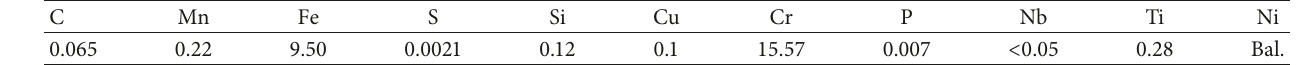
Table 1: Chemical composition of Alloy 600